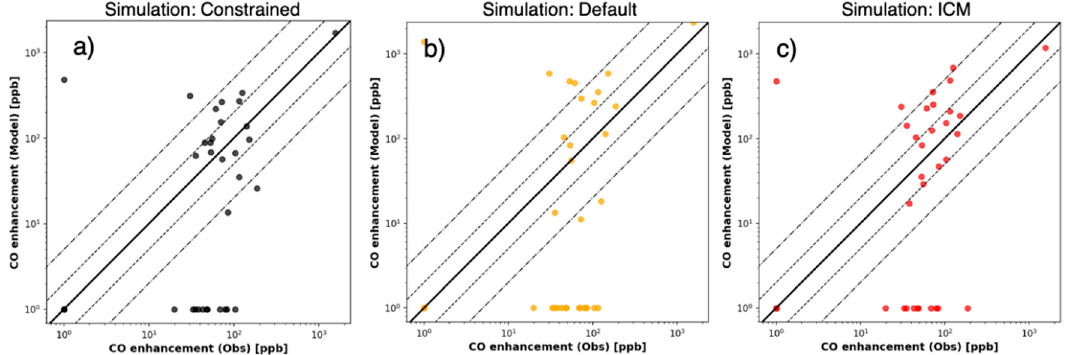
Figure 8. Scatterplots of observed vs. modeled enhancements in CO (ppb) on a logarithmic scale during the L2F prescribed burn between 18:00–20:59 UTC. The innermost dashed line represents differences within a factor of 2.5, while the outermost dashed lines mark results with differences that are within a factor of 5. ( a ) Measured enhancements, and modeled enhancements using the ( b ) default and ( c ) ICM configurations.